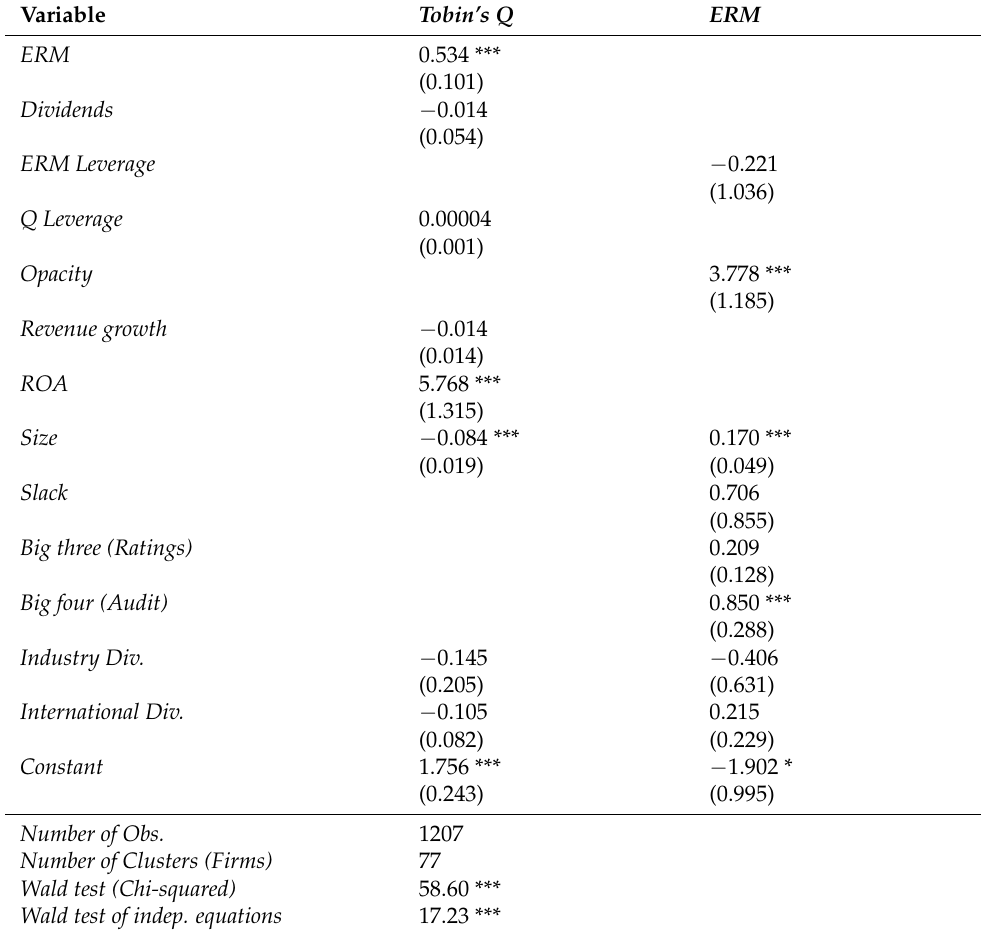
Table 5. Full maximum likelihood treatment effects model—Tobin’s